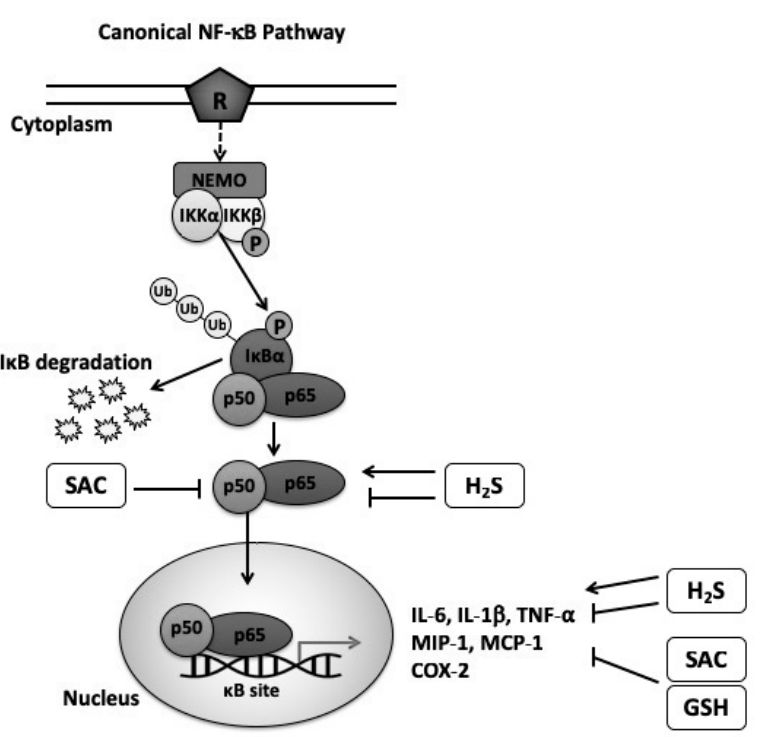
Figure 1. Schematic illustration of the proposed mechanism by which GSH, SAC and H 2 S affect the activation of the canonical NF- κ B pathway. The canonical NF- κ B pathway is the major pathway responsible for controlling inflammatory events through translocation of p50/p65 heterodimer to the nucleus. This event induces the production of pro-inflammatory cytokines and other chemochines, such as IL-6, TNF- α , IL-1 β , MIP-1 α , MPC-1 and COX-2 enzyme. It has been suggested that GSH has anti-inflammatory effects by reducing the levels of pro-inflammatory cytokines production. SAC, a constituent from AGE, has been shown to inhibit p50/p65 activation and the levels of pro-inflammatory cytokines. Contrarily, H 2 S seems to have both inhibitory and activating effects in the NF- κ B pathway. Abbreviations: R (receptor); NF- κ B (nuclear factor kappa-light-chain-enhancer of activated B cells); NEMO (NF-kB essential modulator); I κ B (inhibitor of kappa B); I κ B α (inhibitor of kappa B alpha); IKK α (I κ B kinase alpha); IKK β (I κ B kinase beta); P (phosphorylation); Ub (ubiquitination); TNF- α (tumor necrosis factor-alpha); MIP-1 (macrophage inflammatory protein-1); MCP-1 (monocyte chemoattractant protein-1); COX2 (cyclooxygenase-2), SAC (S-allyl cysteine); GSH (glutathione), H 2 S (hydrogen sulfide).